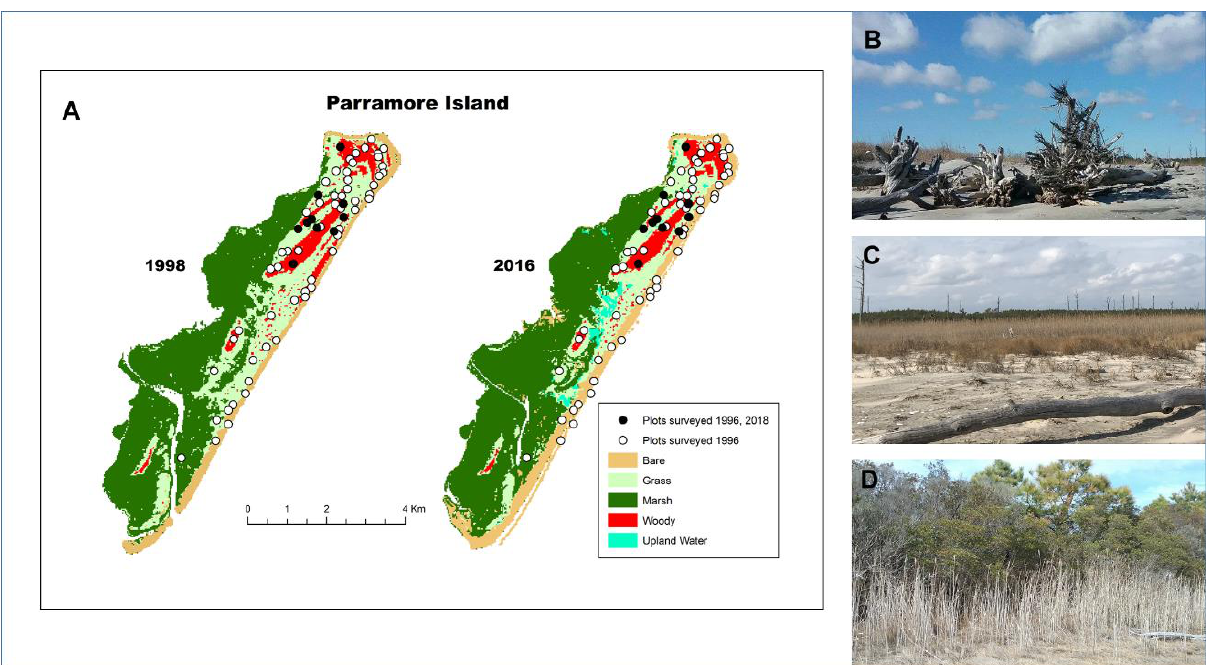
Figure 4. ( A ) Over the 21-year period, >60% of the forested plots on Parramore Island, VA exhibited transition to other states: 31% woody vegetation converted to grassland and 33% were lost to non-vegetative beach or ocean as a result of erosion. Only 33% of the surveyed plots remained as woody vegetation; ( B ) Ghost forest on the oceanside beach (denoted as Bare); ( C ) Dead tree trunks in a grassland area (denoted as Grass); ( D ) Maritime forest with encroaching M. cerifera shrub (denoted as Woody).